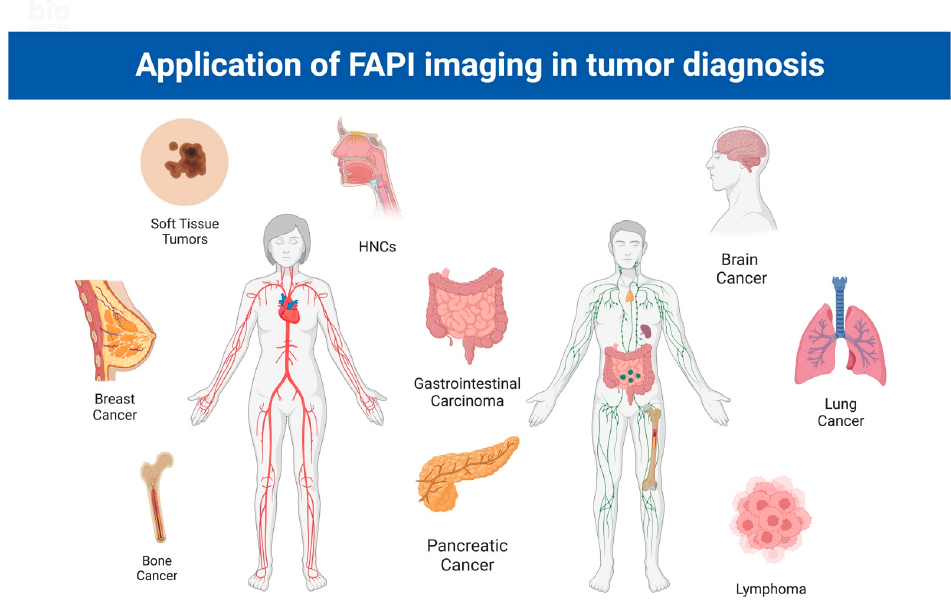
Figure 2. Application of FAPI imaging in various tumor diagnoses and management. HNC: head and neck carcinoma.